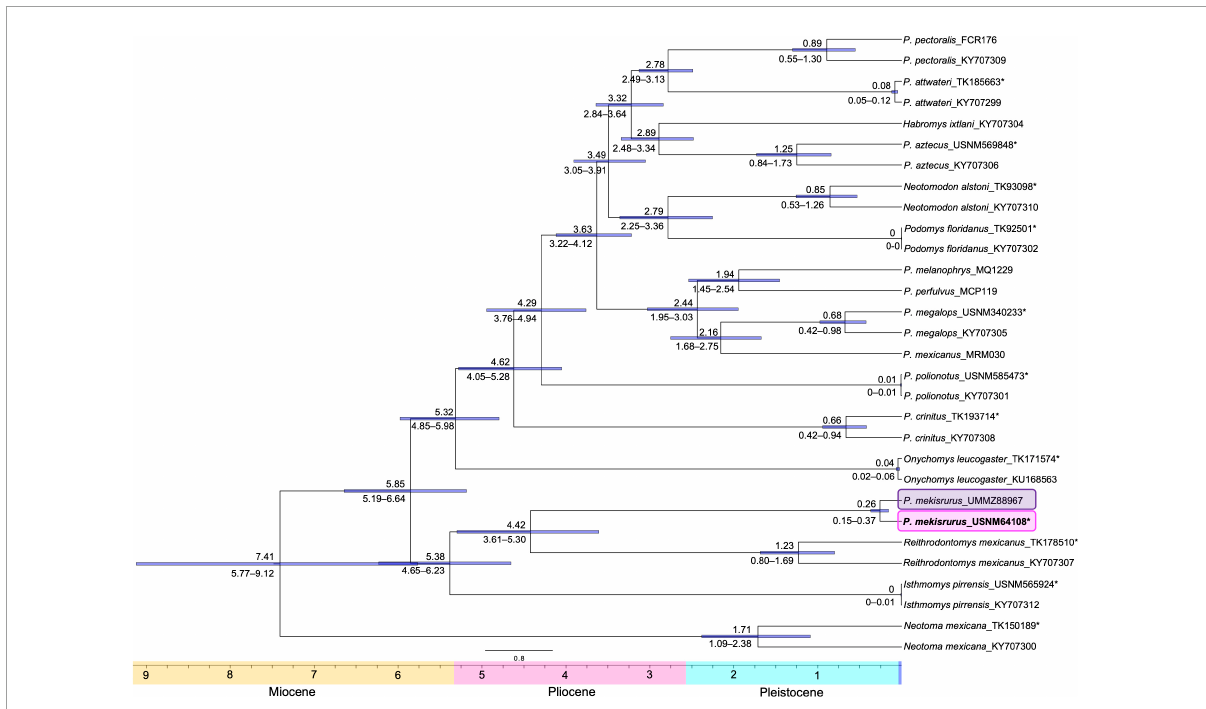
FIGURE5 Divergence dated whole mitochondrial genome phylogeny. Dates above the branches are provided in millions of years. Blue horizontal bars and numbers below the branches show the 95% confidence intervals. The pink block highlights the phylogenetic position of the Peromyscus mekisturus holotype collected in 1898, and the purple block shows the position of the second specimen collected in 1947. Asterisks* denote specimens that were sequenced from museum specimens for this study and compared with previous GenBank accessioned mitogenome